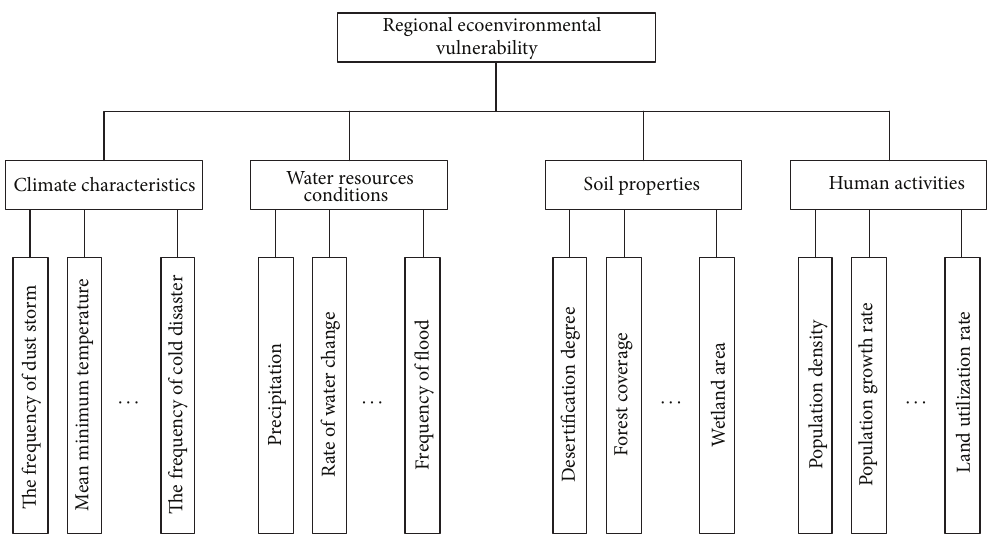
Figure 1: Evaluation index system of ecoenvironmental